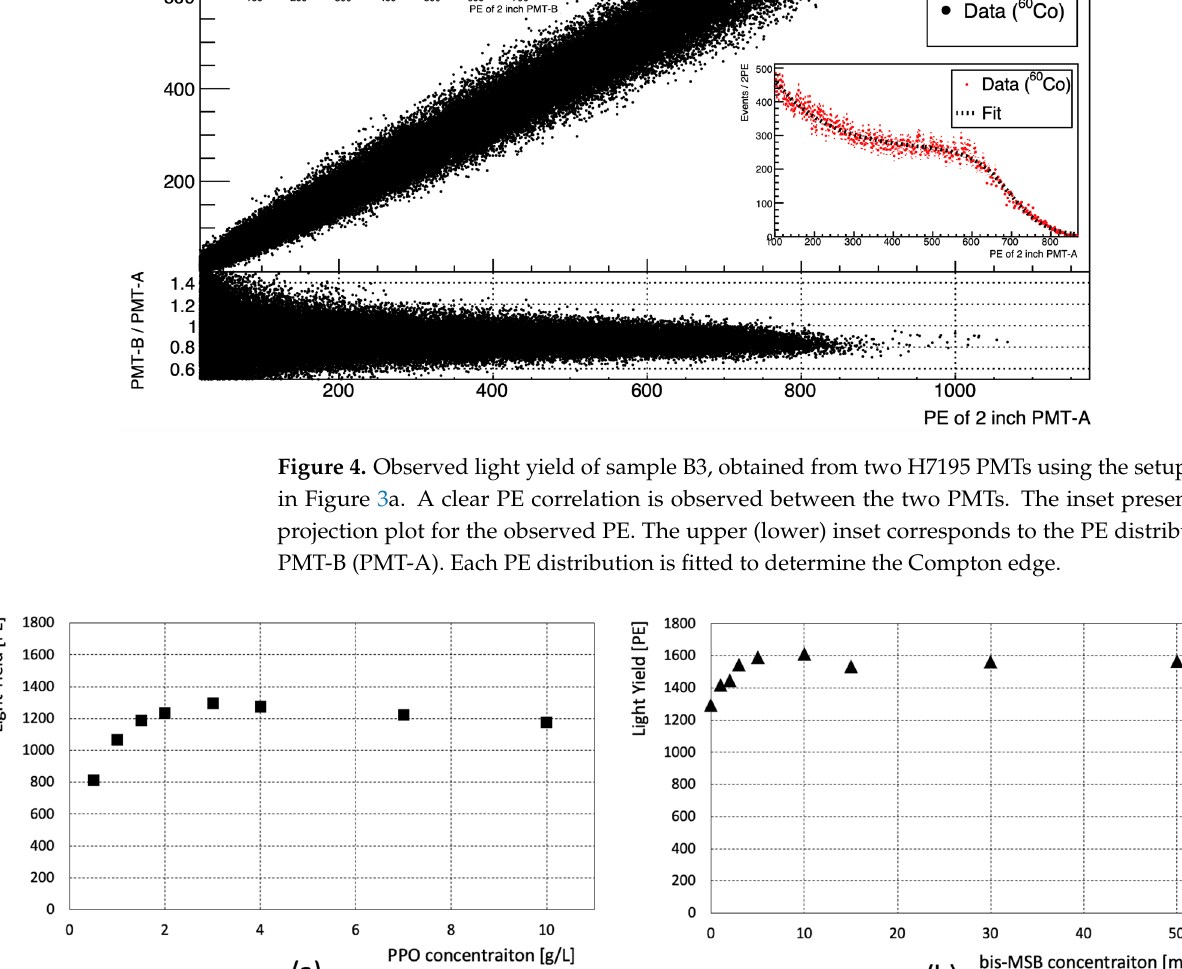
Figure 5. ( a ) Scintillation light yield with different PPO concentrations; ( b ) Light yield with different bis-MSB concentrations. The PPO concentration is constant at 3 g/L in ( b